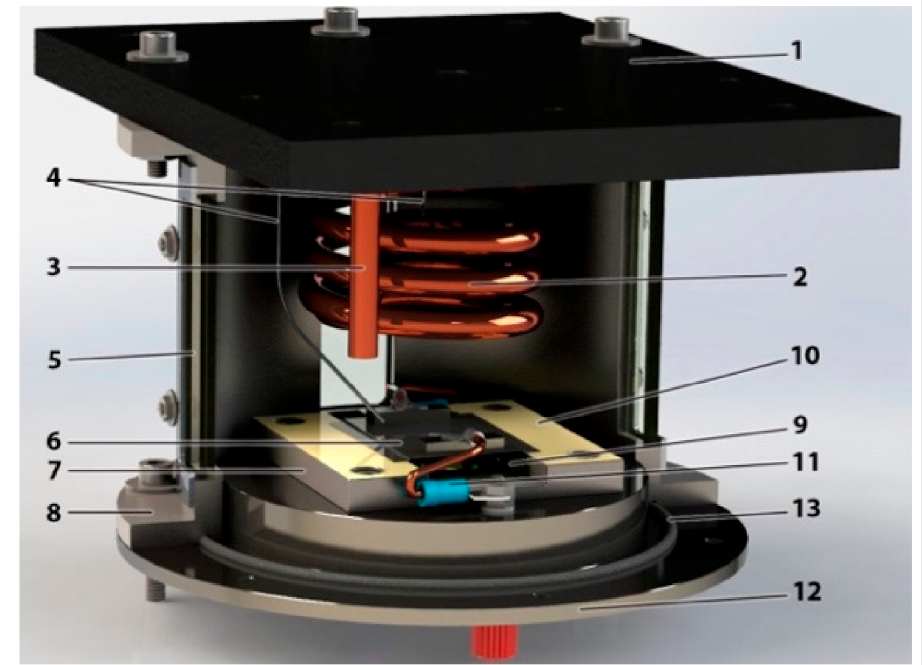
Figure 2. Assembled model of the boiling chamber and its components: ( 1 ) support, ( 2 ) coil heater, ( 3 ) cartridge heater, ( 4 ) thermocouples, ( 5 ) window, ( 6 ) test surface, ( 7 ) test surface base, ( 8 ) tank, ( 9 ) thermal glass, ( 10 ) Kapton tape, ( 11 ) copper wire, ( 12 ) tank base and ( 13 )